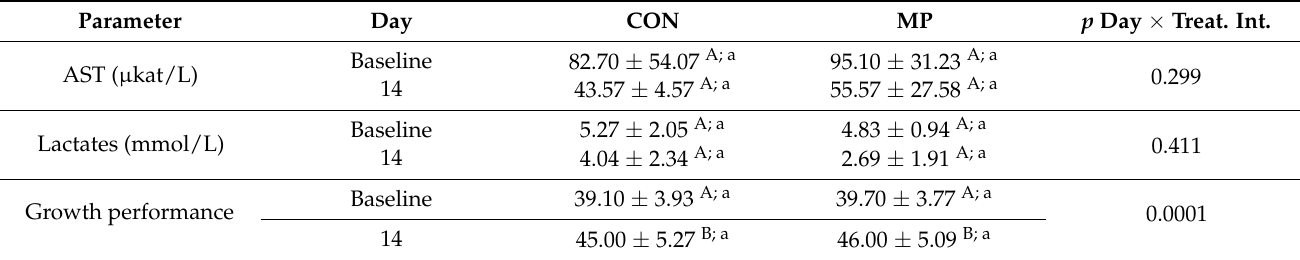
Table 1. Blood parameters and growth performance of calves fed with milk replacer only (CON group) or supplemented with fermented milk permeate (MP